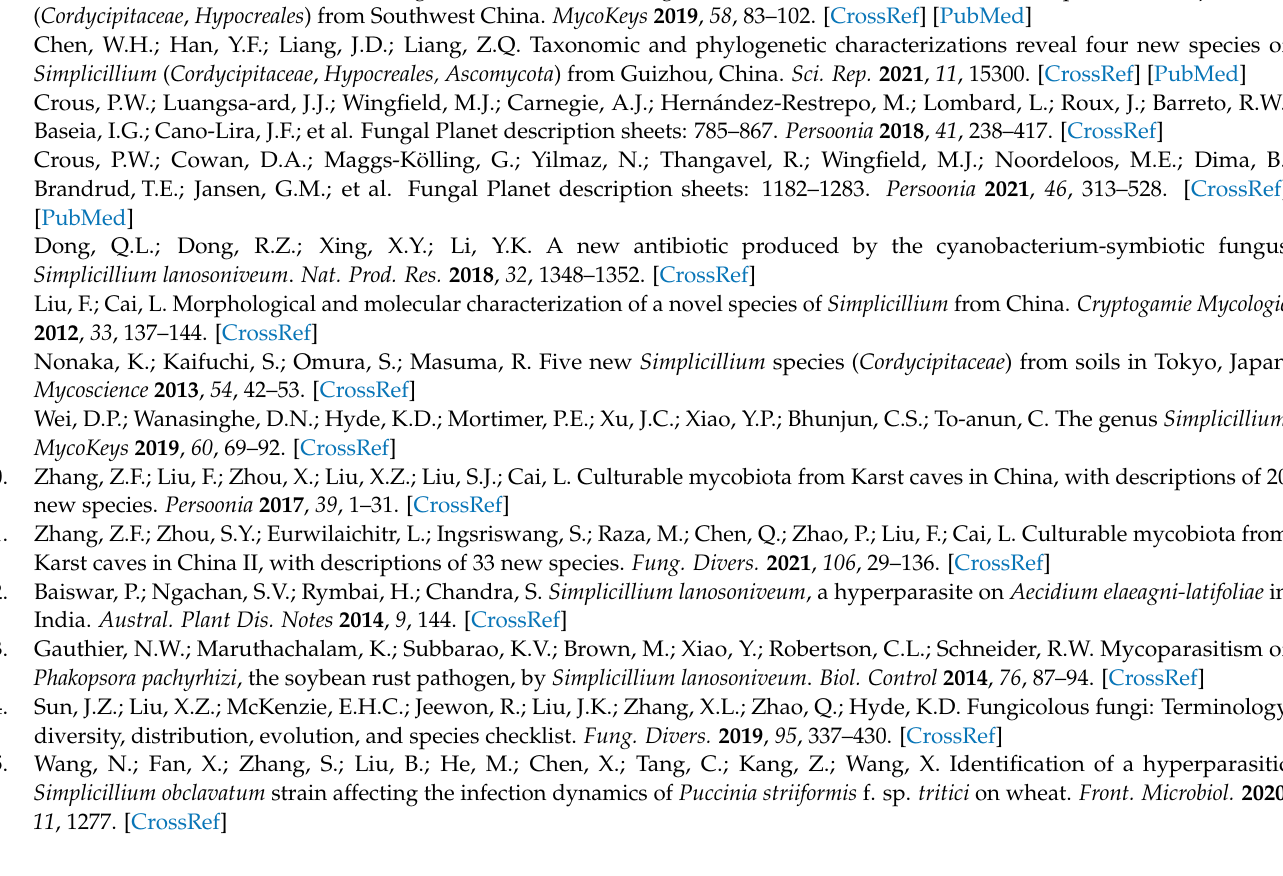
Table S5: Reagents for RT-PCR to detect expression of defense-related genes in seedlings of oilseed rape; Table S6: Thermal program for quantitative RT-PCR to detect expression of defense-related genes in seedlings of oilseed rape; Table S7: Gene clusters for biosynthesis of secondary metabolites (SMs) in the S. lamellicola JC-1 strain; Table S8: Putative genes of the verlamelin biosynthesis gene cluster in S. lamellicola